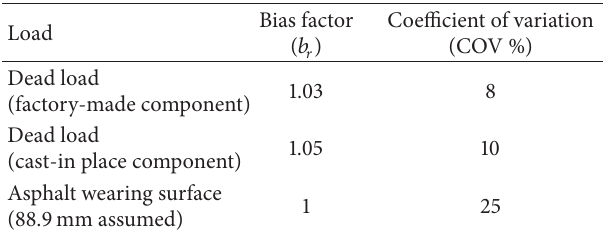
Table 1: Dead load Statistics [13].